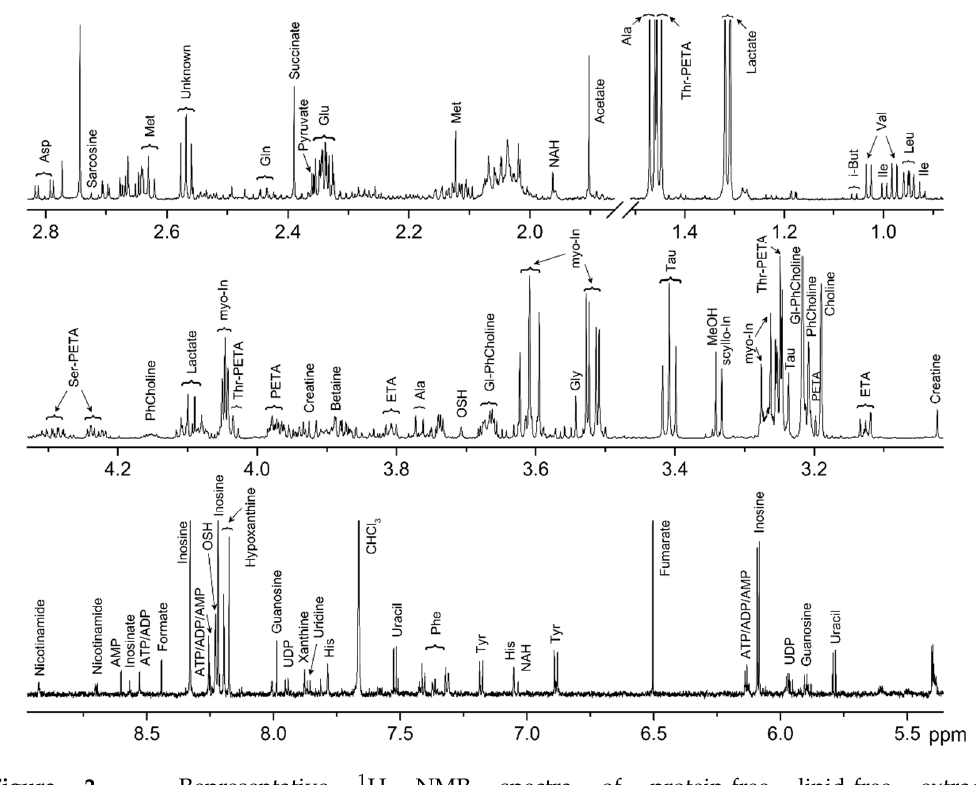
Figure 2. Representative 1 H NMR spectra of protein-free lipid-free extract from S. lucioperca gill with the metabolite assignment: ETA—ethanolamine; Gl-PhCholine—glycerophosphocholine; NAH— N- acetyl-histidine; OSH—ovothiol A; PETA—phosphoethanolamine; PhCholine—phosphocholine; scyllo-In— scyllo -inositol; Ser-PETA—serine phosphoethanolamine; Tau—taurine; Thr-PETA—threonine phosphoethanolamine. For amino acids and nucleotides, standard 3-letter symbols are